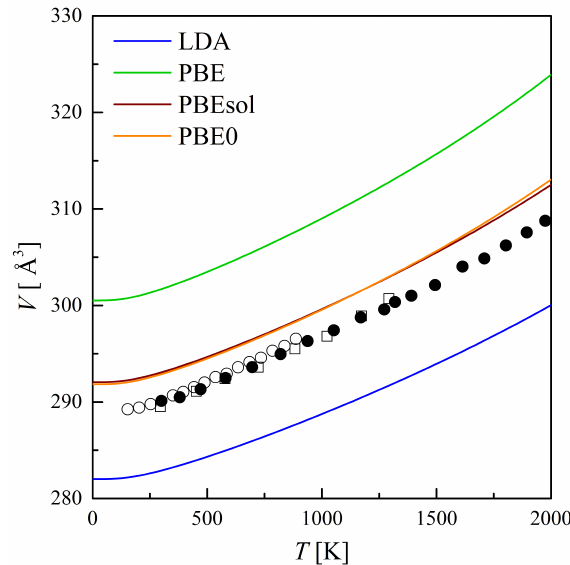
Figure 1. Volumetric thermal expansion of forsterite up to 2000 K. Experimental data are from Bouhifd et al. [55] (filled circles), Ye et al. [56] (empty circles) and Hazen [57] (empty squares). Lines correspond to quasi-harmonic computed values with different functionals of the DFT: LDA (blue), PBE (green), PBEsol (red), and PBE0